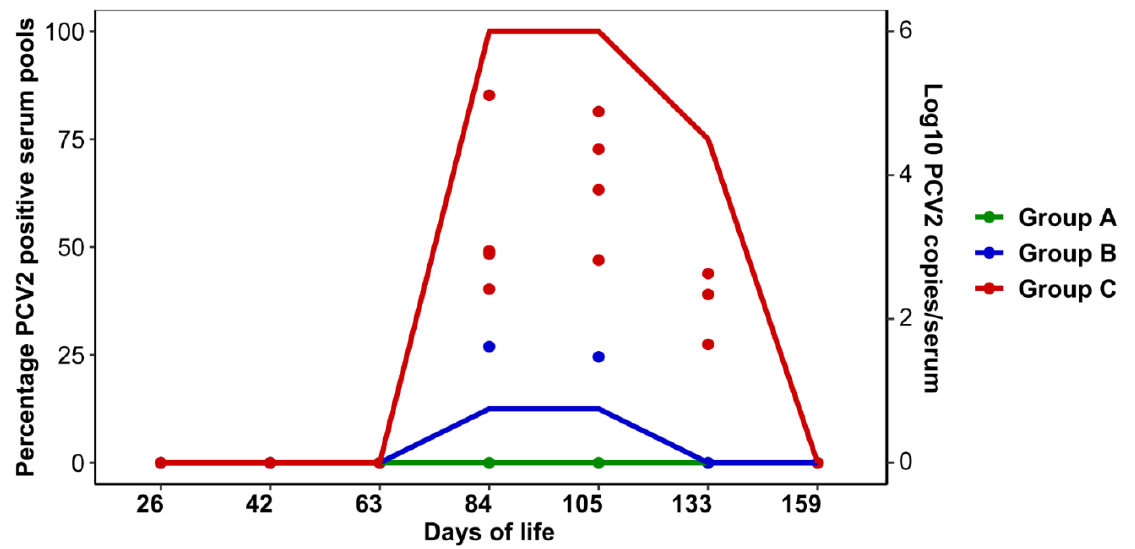
Figure 1. Dynamics of PCV2 viremia in each group. Lines represent the percentage of PCV2 positive serum pools (5 pigs/pool) at each age. Points represent the number of PCV2 copies/mL of serum in positive pools.